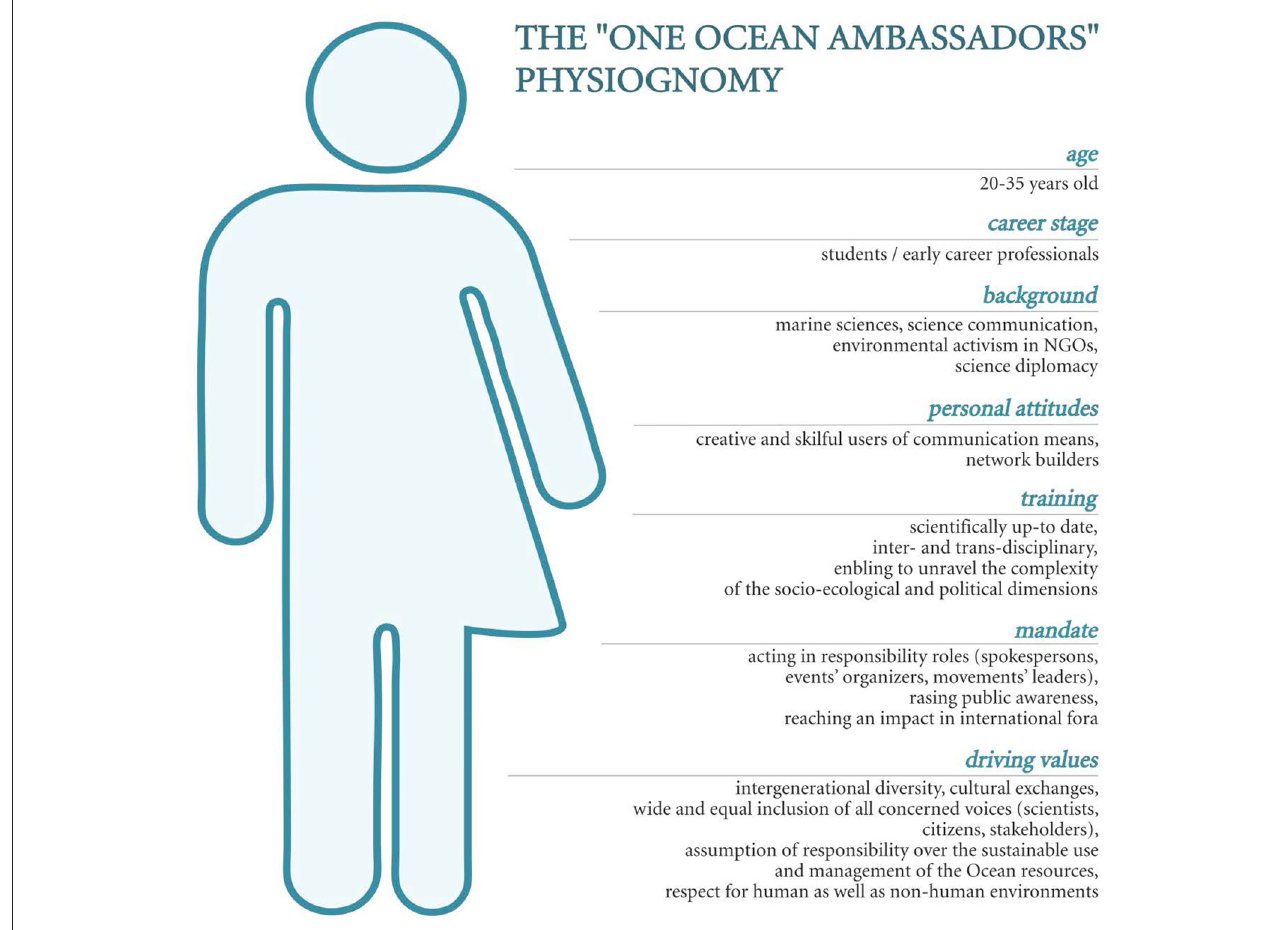
FIGURE 1 | The physiognomy of the “One Ocean Ambassadors” emerging from the comparison of current marine ambassadors